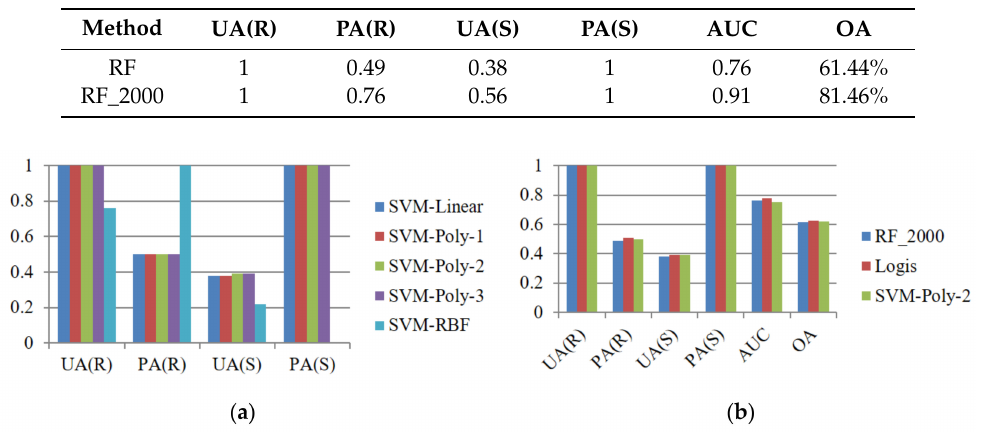
Table 5. Performance of the No. 5 model using the RF method with a cost of 2000, where OA, AUC, PA, UA, S, and R represent the overall accuracy, area under the ROC curve, producer’s accuracy, user’s accuracy, landslide source, and runout, respectively.